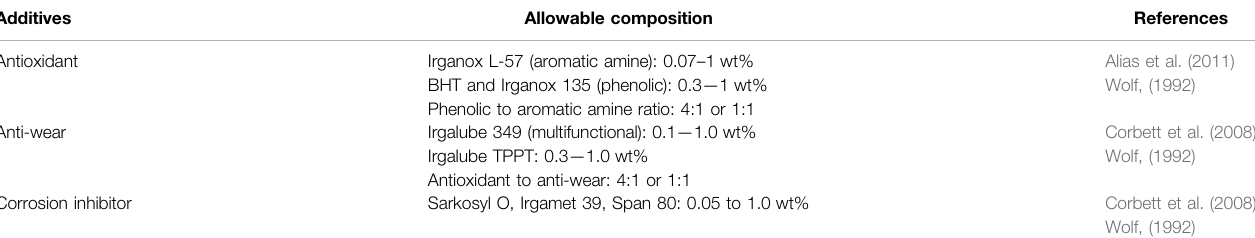
TABLE 4 | Allowable composition of food grade additives in